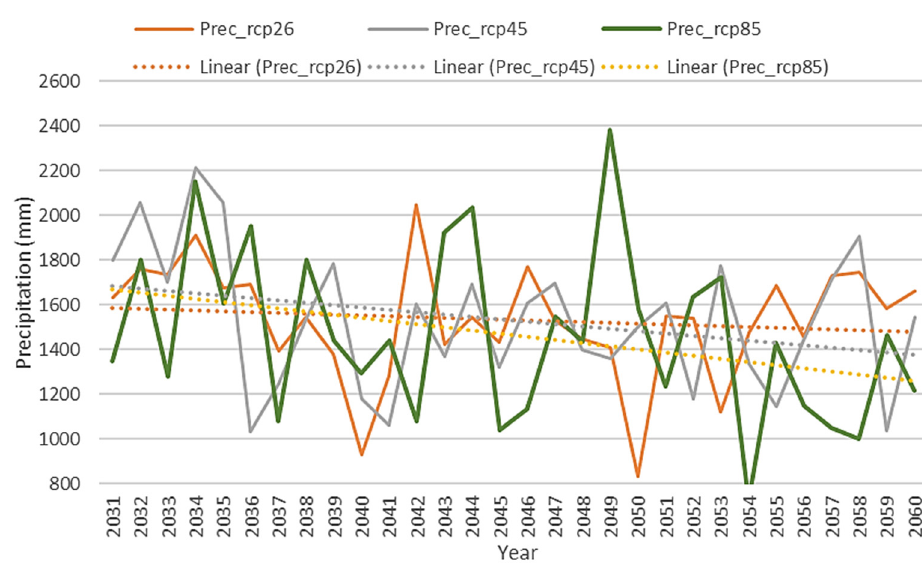
Figure 3. Annual precipitation values for the period 2031–2060 for the 3 climate scenarios .